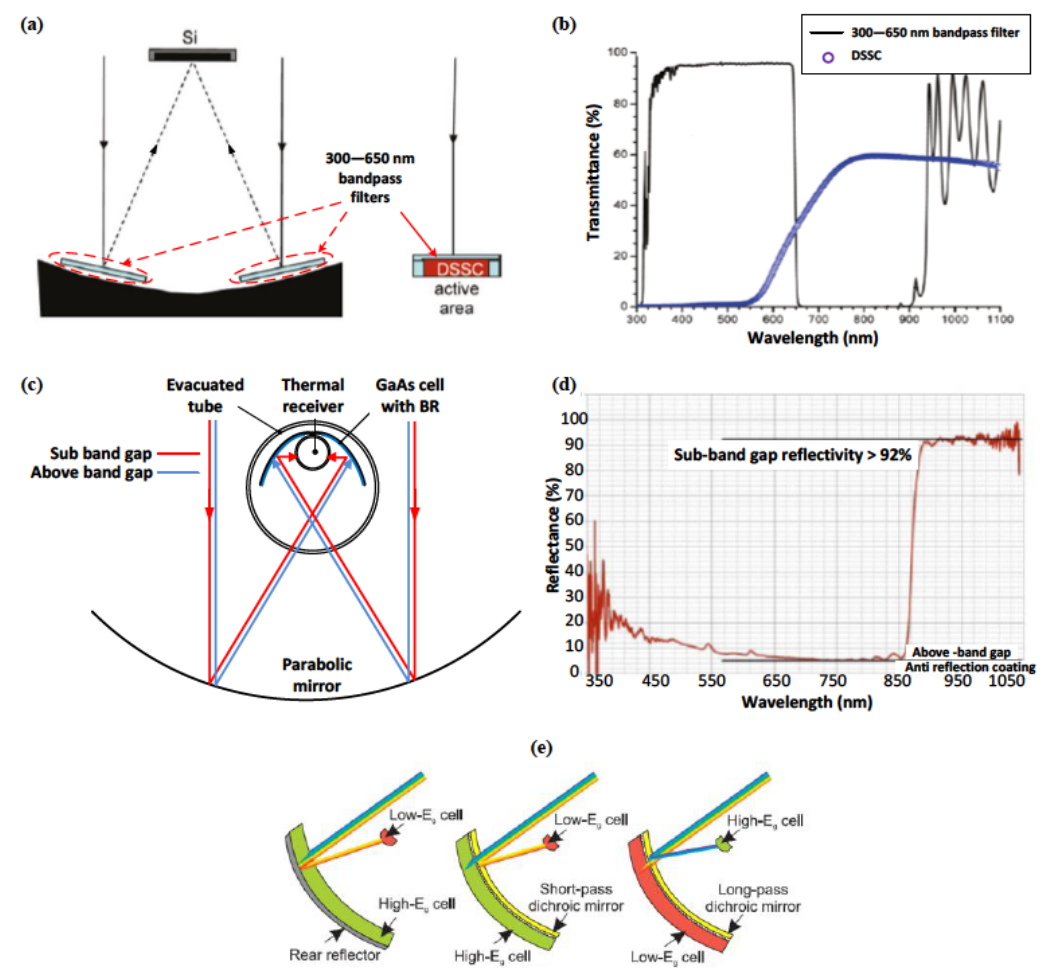
Figure 6: (a) Using PV cells in the structure of concentrating mirrors, the cell is covered with a dichroic reflector, adapted from Barber et al. [40] (DSSC: Dye Sensitised Solar Cell), (b) The spectral transmission of the dichroic reflector in Fig. 6(a), adapted from Barber et al. [40], (c) Using GaAs thin film PV cells in front of a secondary reflector in a concentrating hybrid PV-T system (BR: back reflector), adapted from Winston et al. [41], (d) The reflectance of the back reflector GaAs cell used in Fig. 6(c), adapted from Winston et al. [41], (e) Using low cost thin film PV cell as a coating of linear concentrators